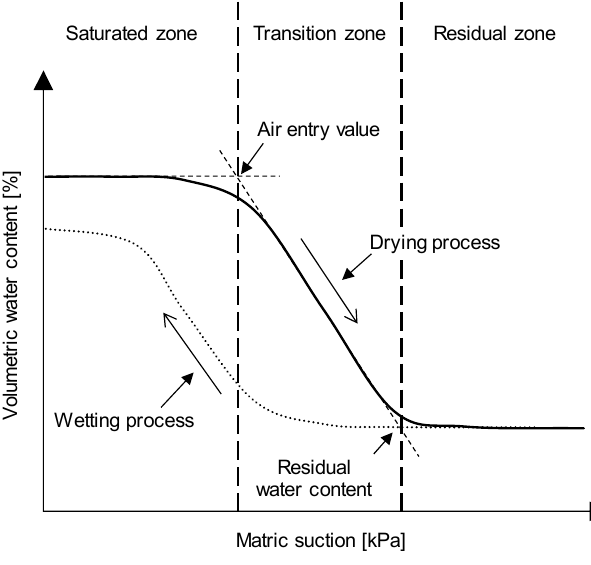
Figure 1. Typical soil-water characteristic curve.